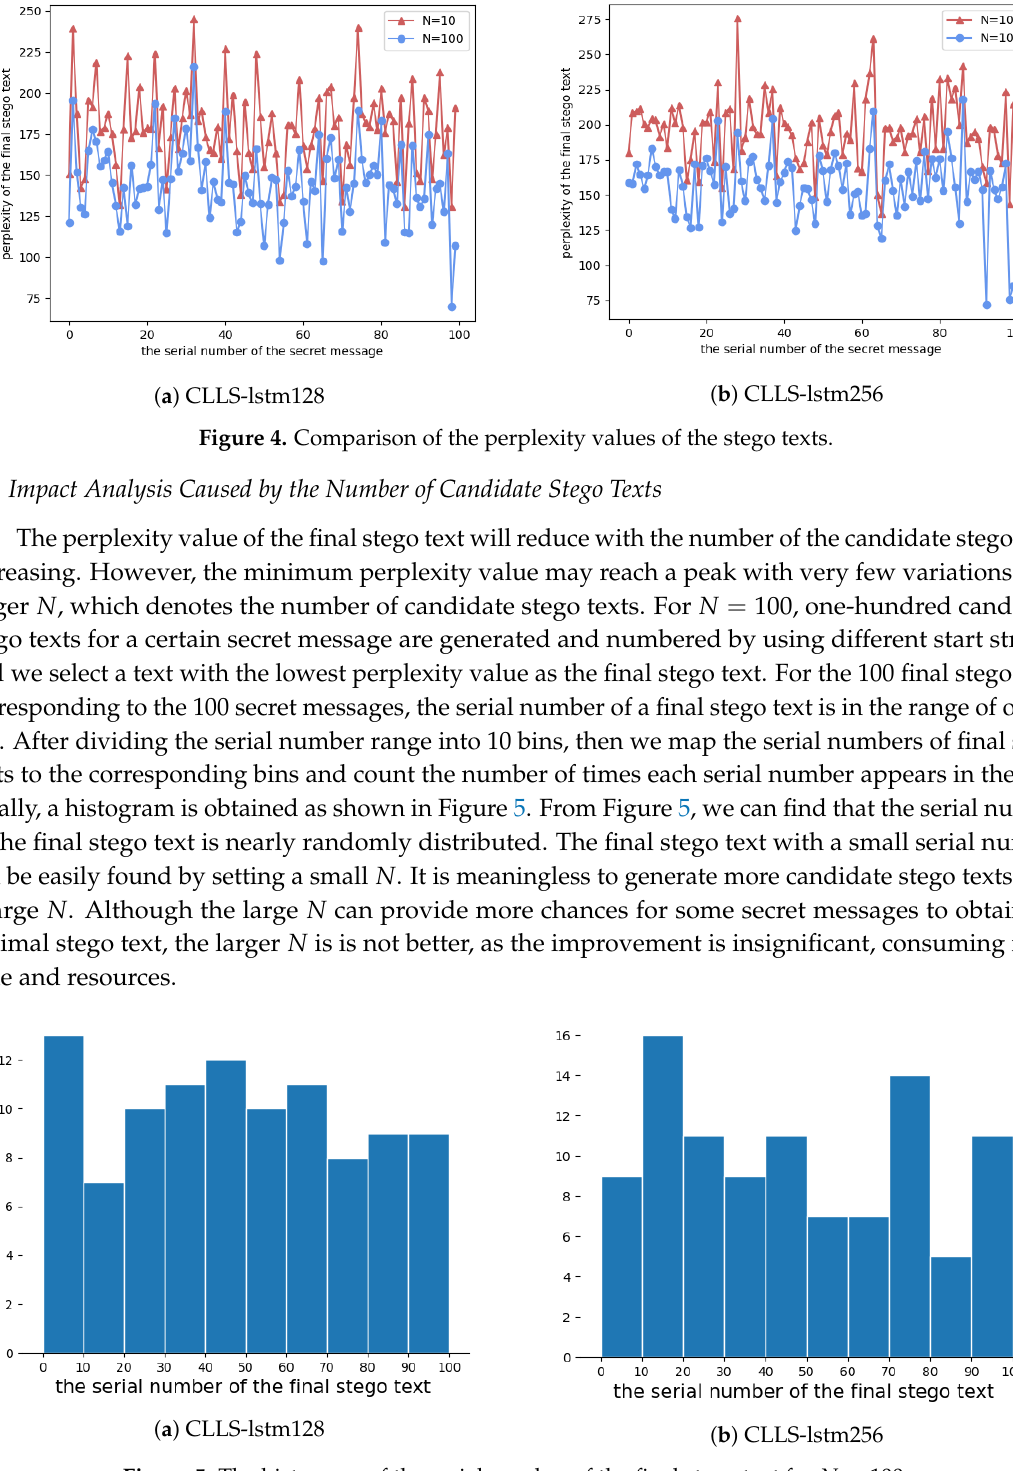
Figure 5. The histogram of the serial number of the final stego text for N =